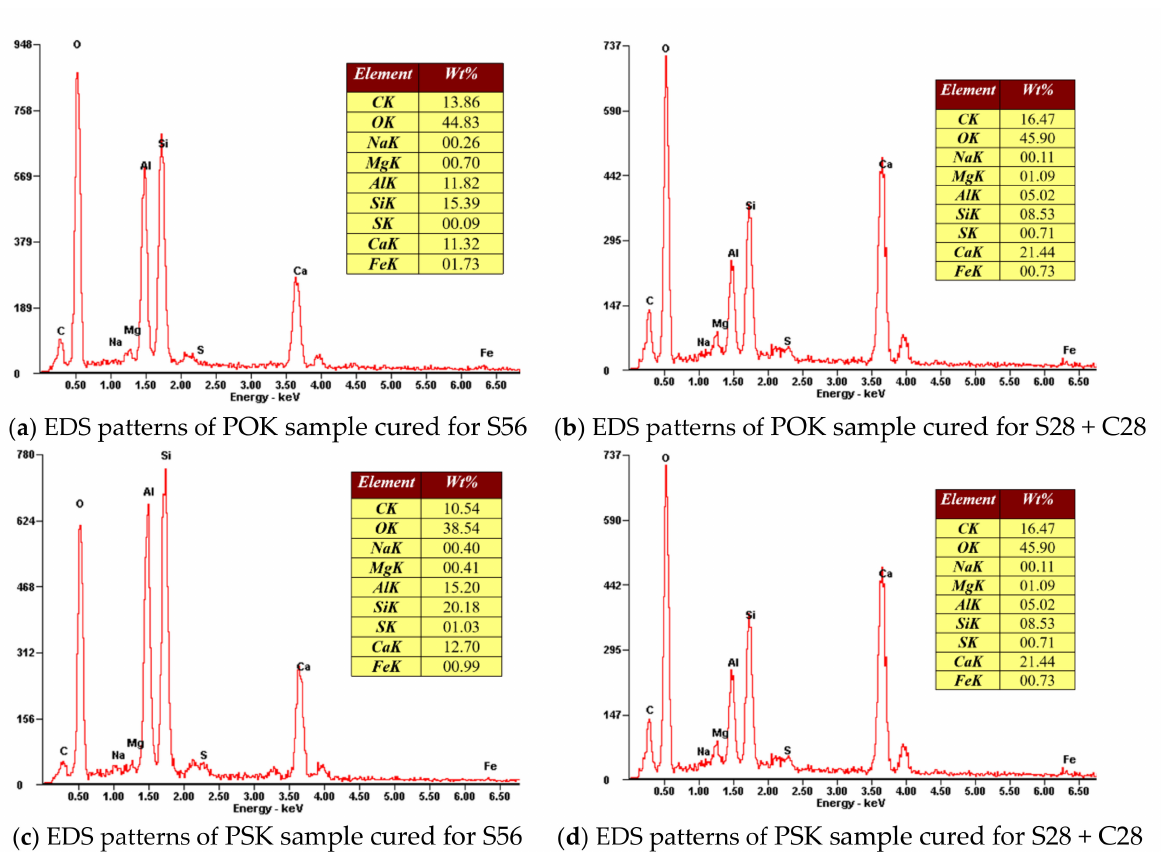
Figure 7. EDS patterns of various